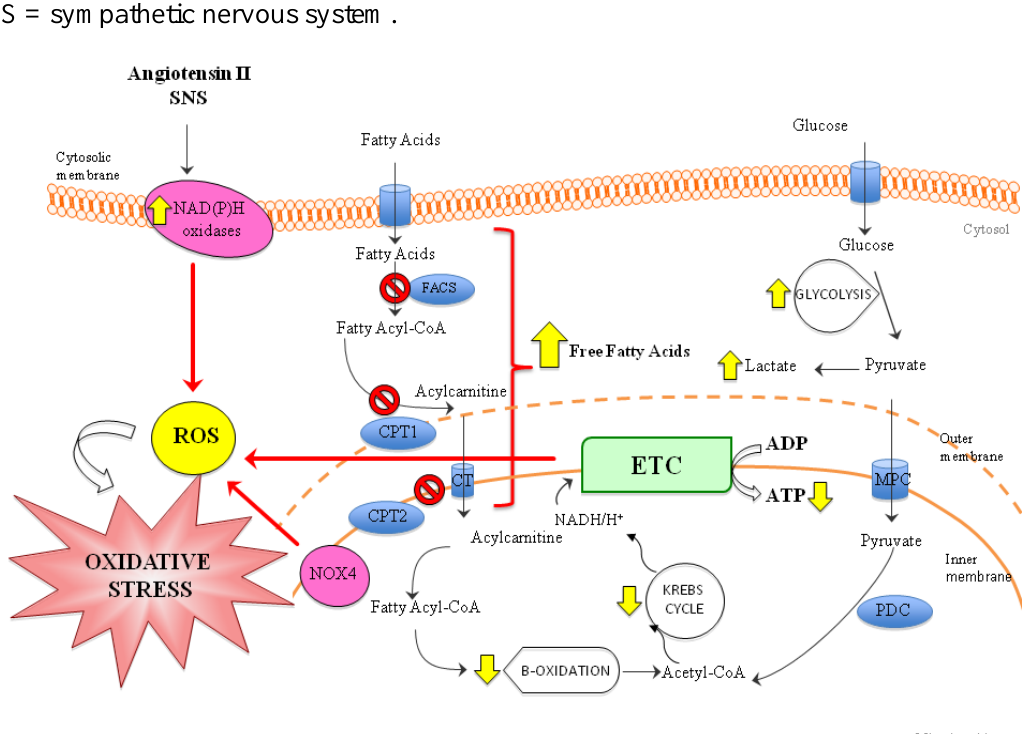
ROS = Reactive oxygen species. RAAS = renin-angiotensin-aldosterone